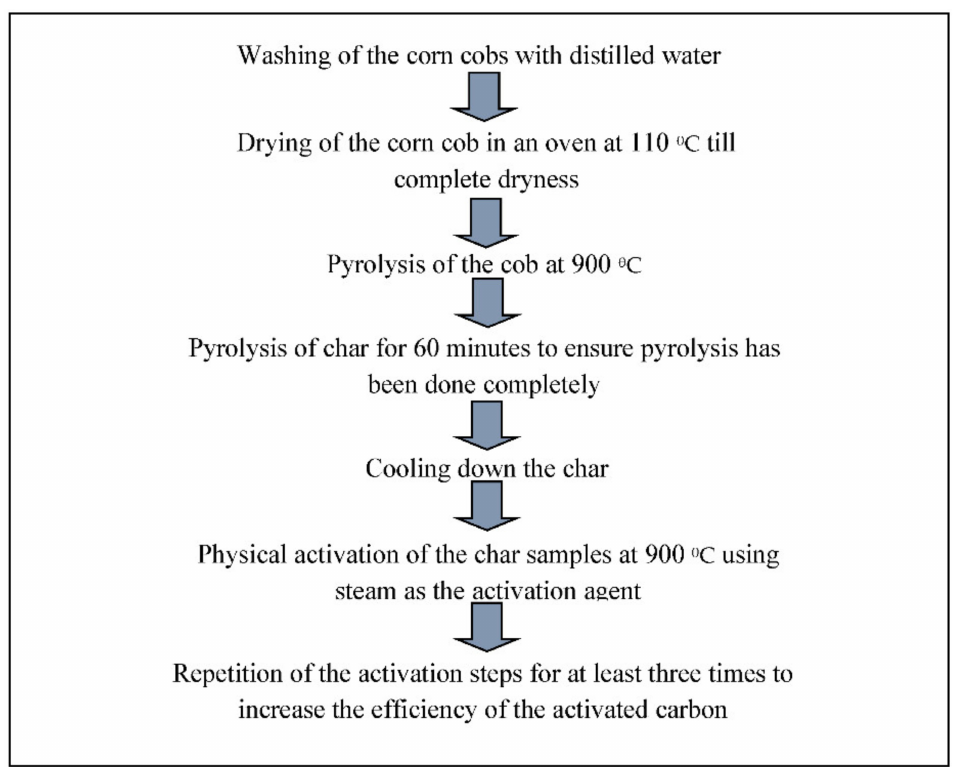
Figure 9. Schematic diagram for the formation of activated carbon from corn